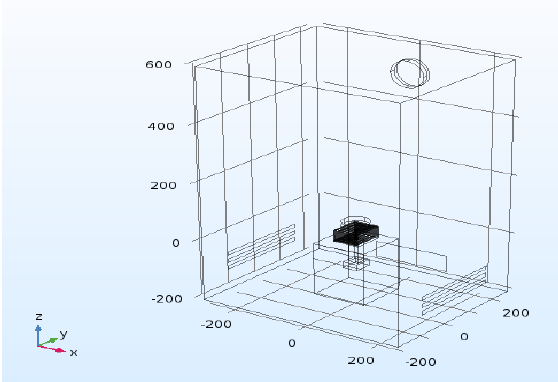
Figure 2. Model for measuring the thermal resistance of heat dissipation.